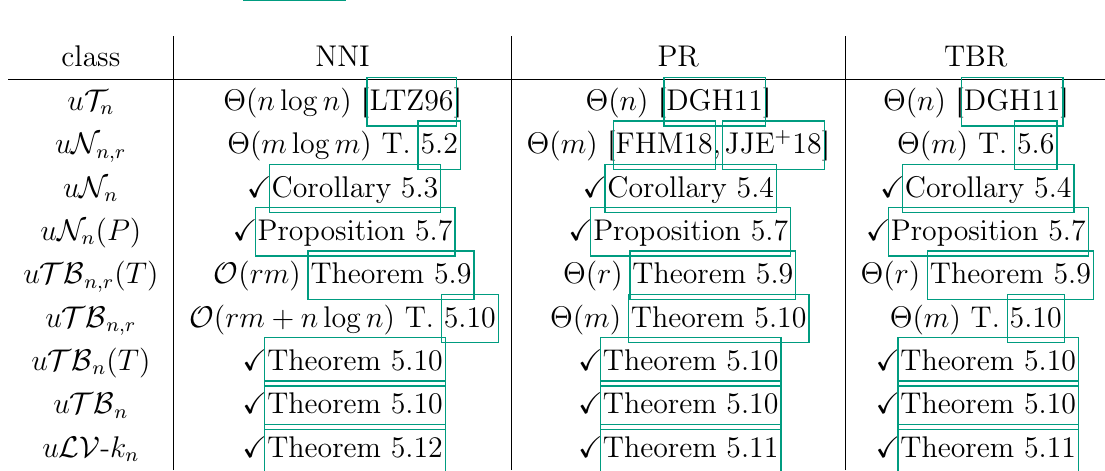
Table 1: Connectedness and diameters, if bounded, for the various classes and rearrange- ment operations. Here m = n + r , P is a set of phylogenetic networks, and T ∈ u T